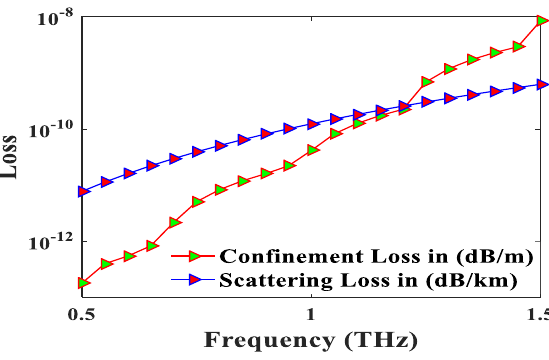
Figure 4. The confinement loss and scattering loss as a function of frequency.